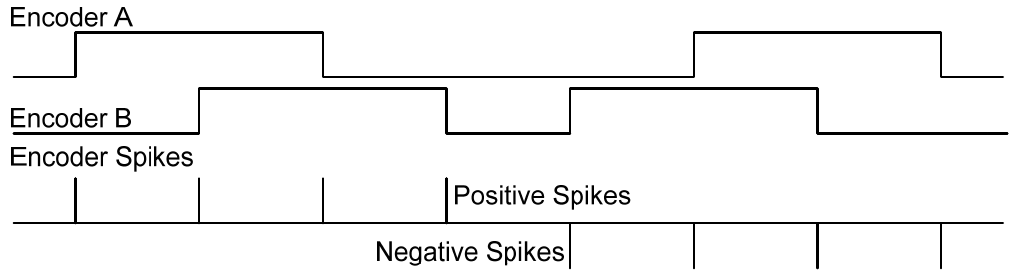
Figure 5. Spikes coming from a quadrature